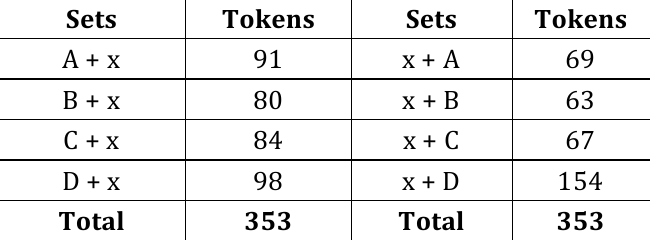
Table 14: Distribution of the four Chinese tones in the two